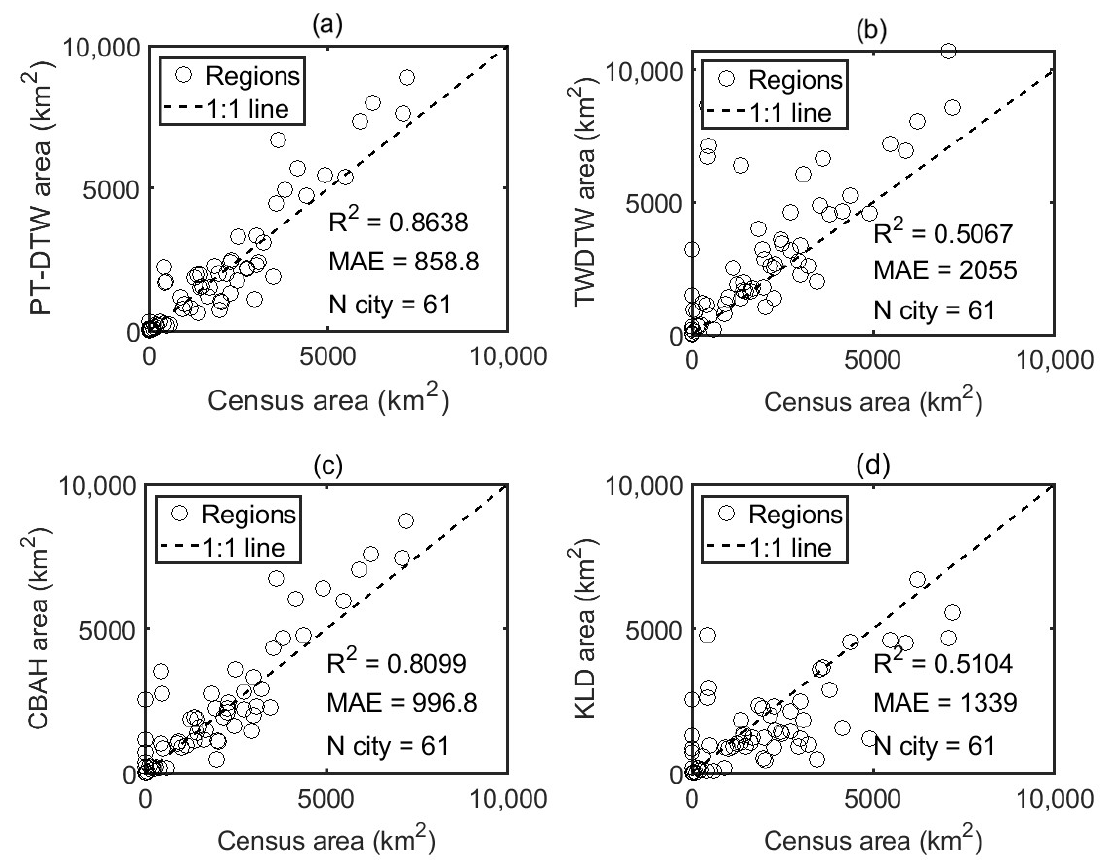
the winter wheat planted areas obtained using the ( a ) PT-DTW method, ( b ) proposed time-weighted Figure 11. Municipal-level agreement between agricultural census data and Sentinel 2 estimations of